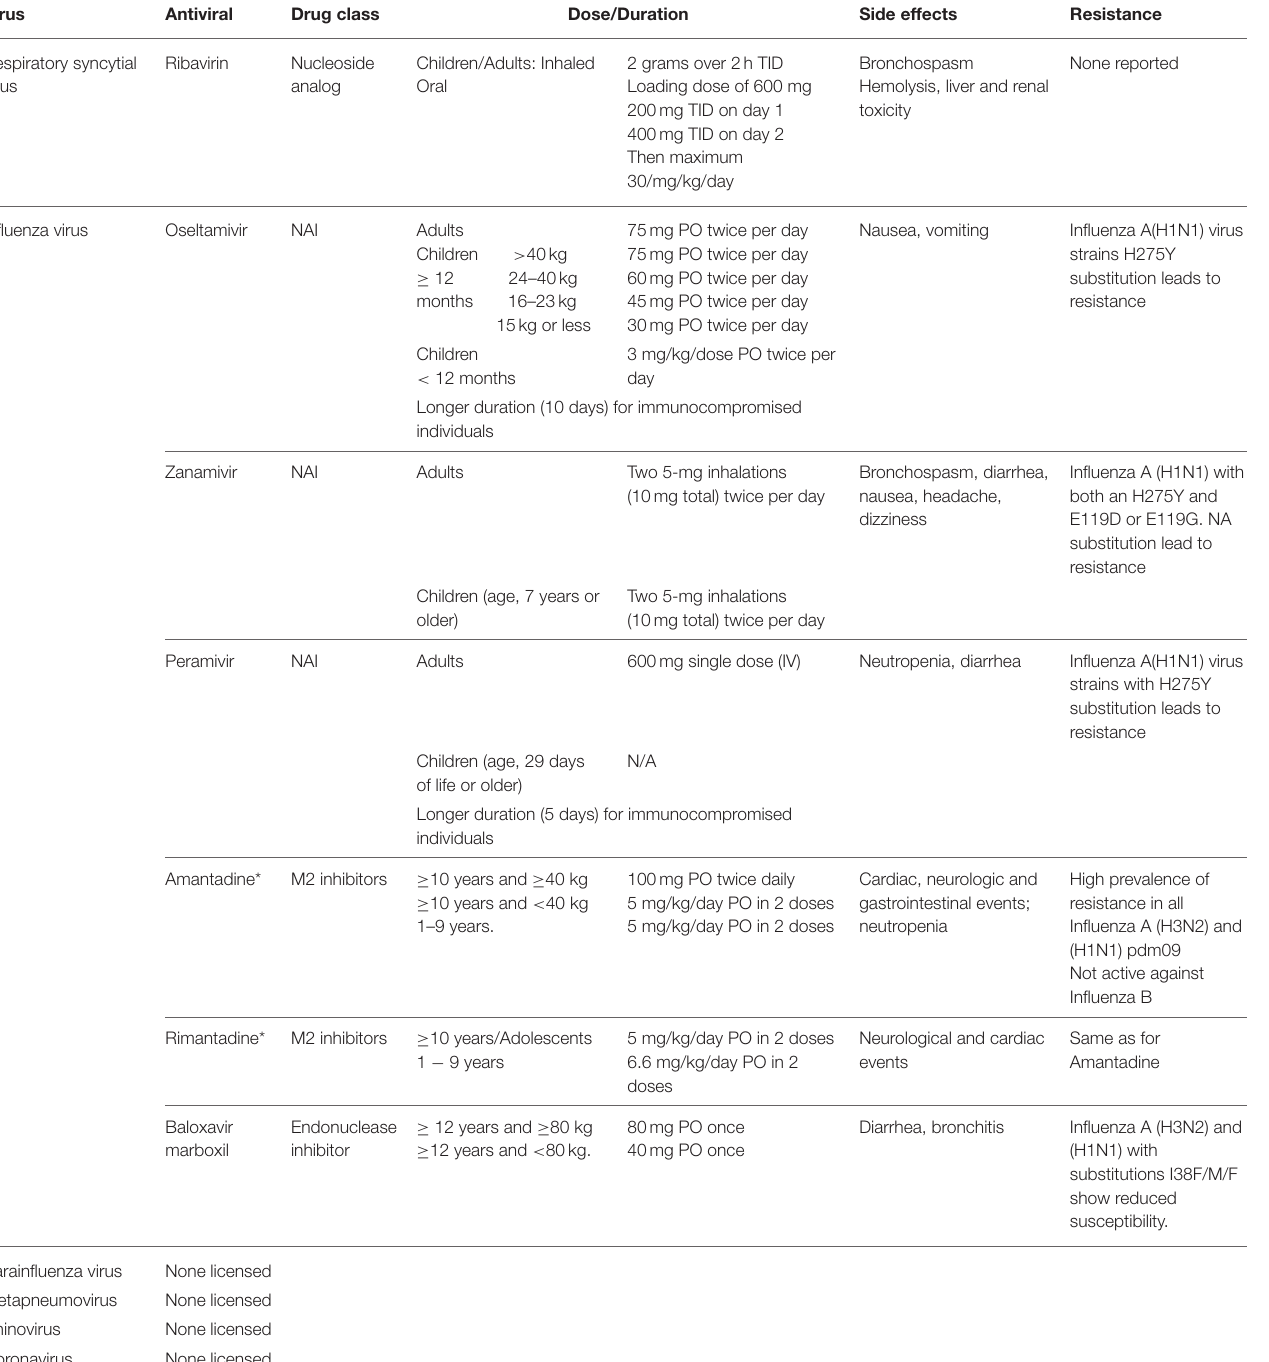
TABLE 3 | Current approved antivirals for treatment of the major human respiratory RNA